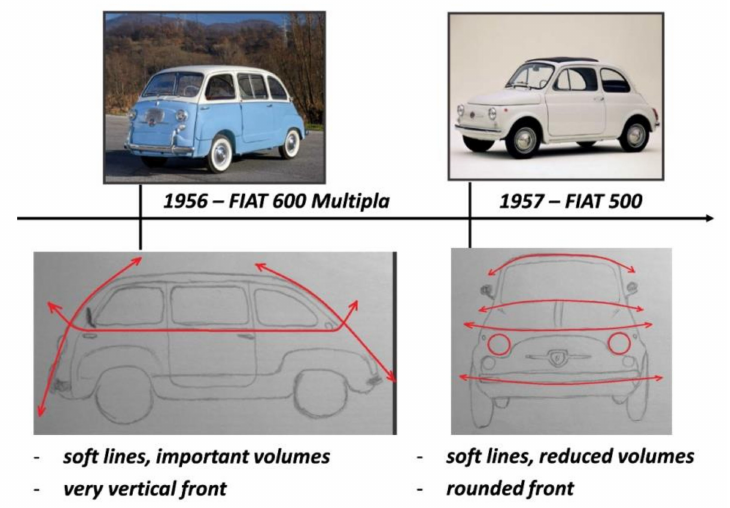
Figure 13. Stylistic evolution of FIAT car city